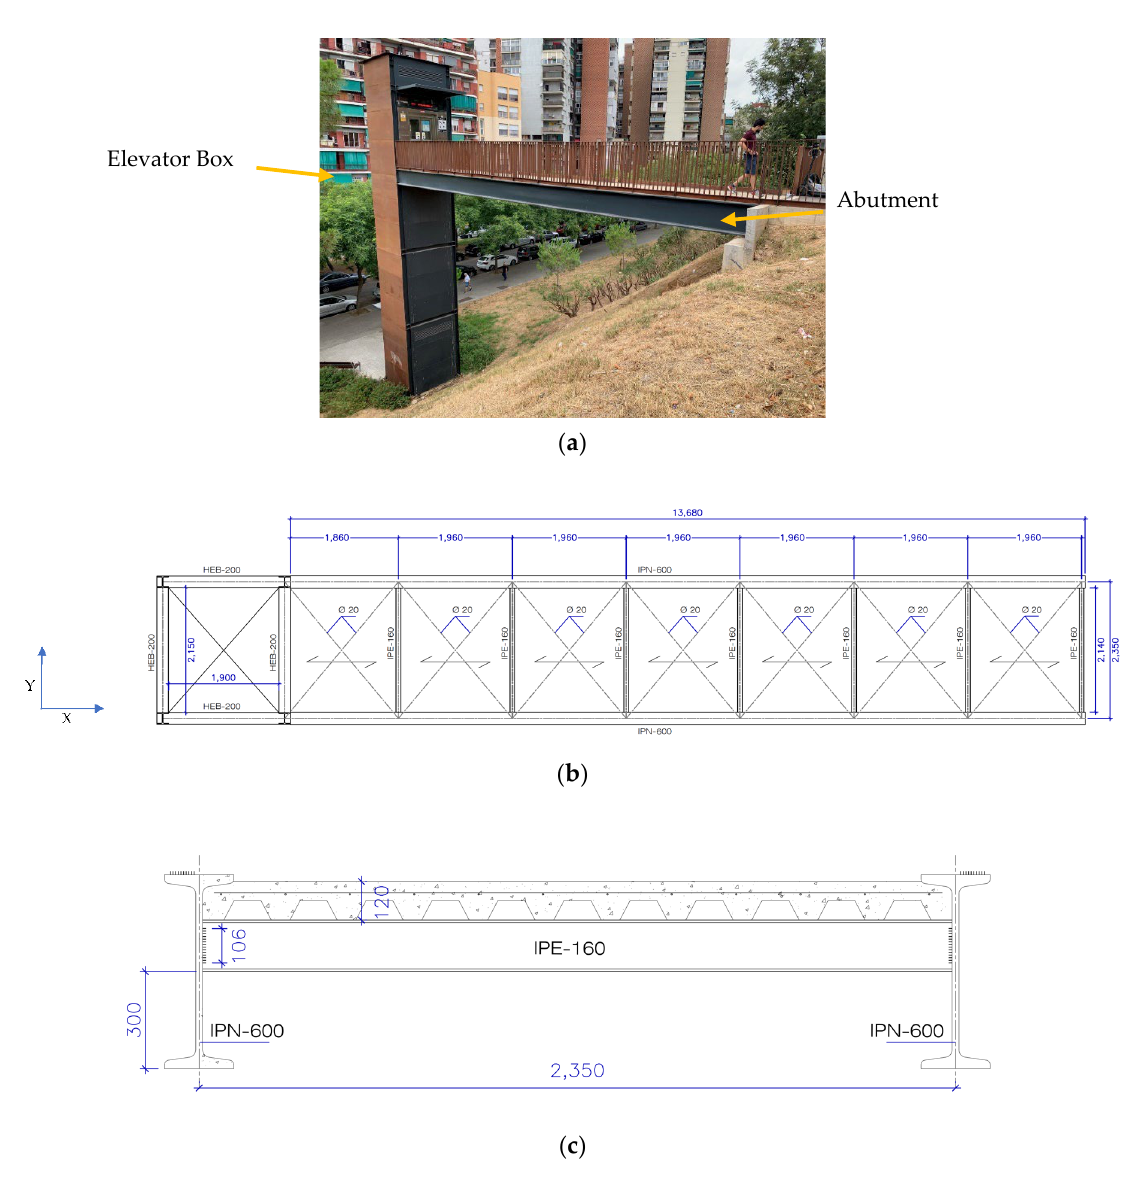
Figure 10. ( a ) A picture of the pass way, ( b ) plan of the bridge, and ( c ) section of the pass way bridge (all units are in mm).